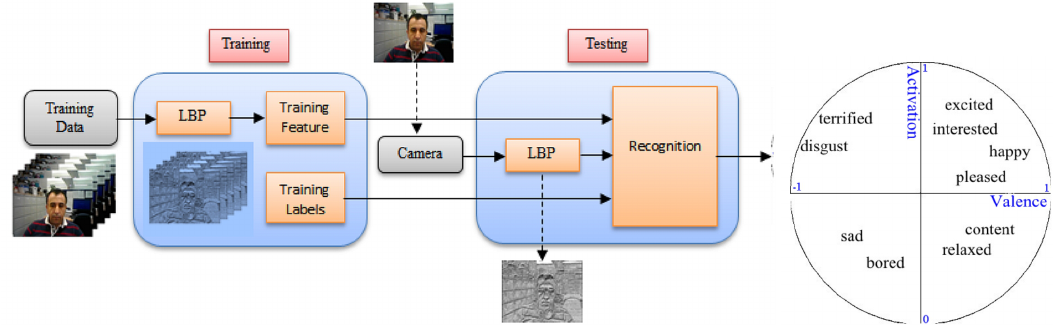
Figure 2. Real-time emotion detection system from facial expression on embedded